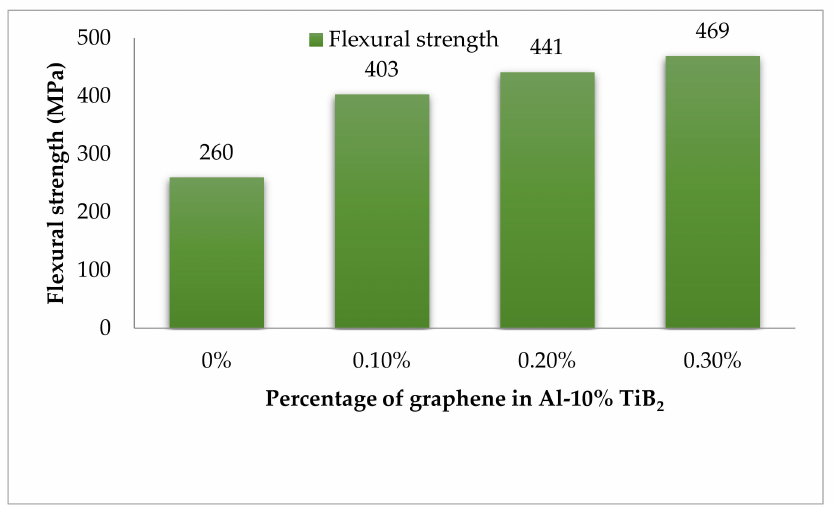
Figure 14. Flexural strength